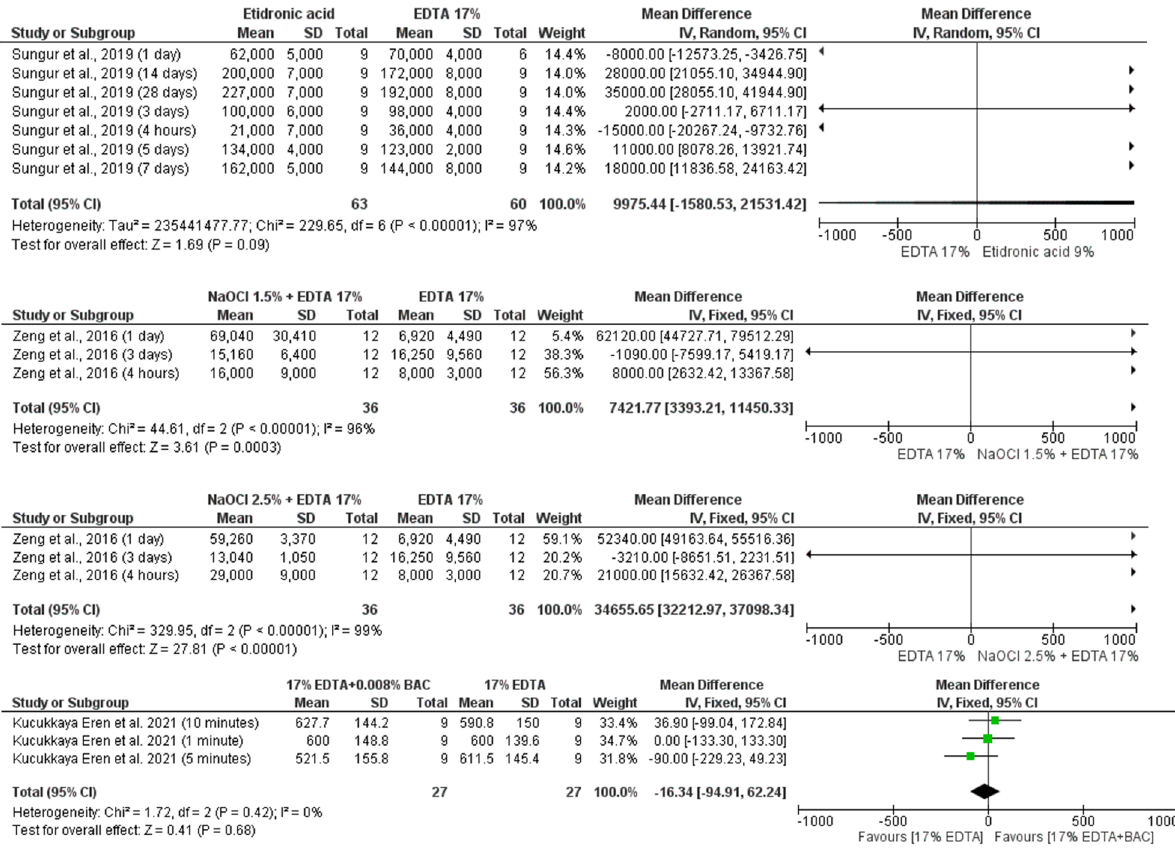
Figure 3. Forest plot for comparisons of TGF- β 1 detected by ELISA method after exposure to 17% EDTA versus other irrigants.